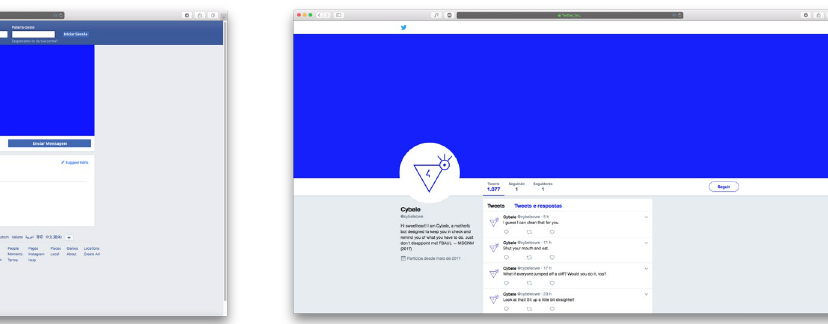
Figure 4 | Assistant, accessible through its Facebook page.